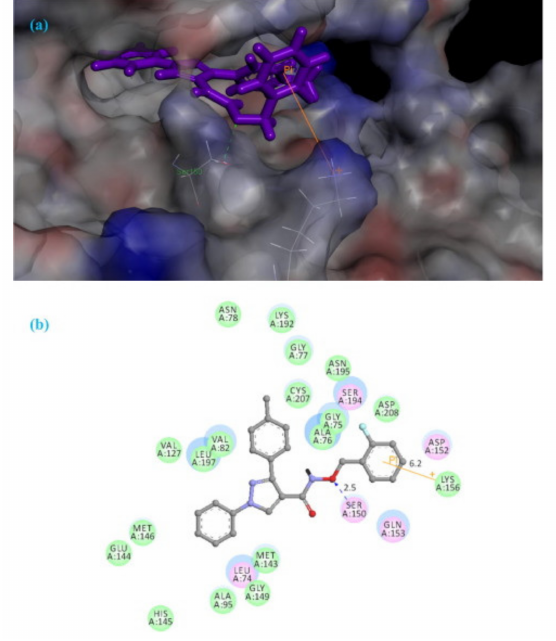
Figure 62. ( a ) Docking pose of compound 56 into the active site of the MEK1 protein-kinase. Hydrogen bond is illustrated as dashed line. ( b ) 2D binding mode of compound 56 with MEK1 active site